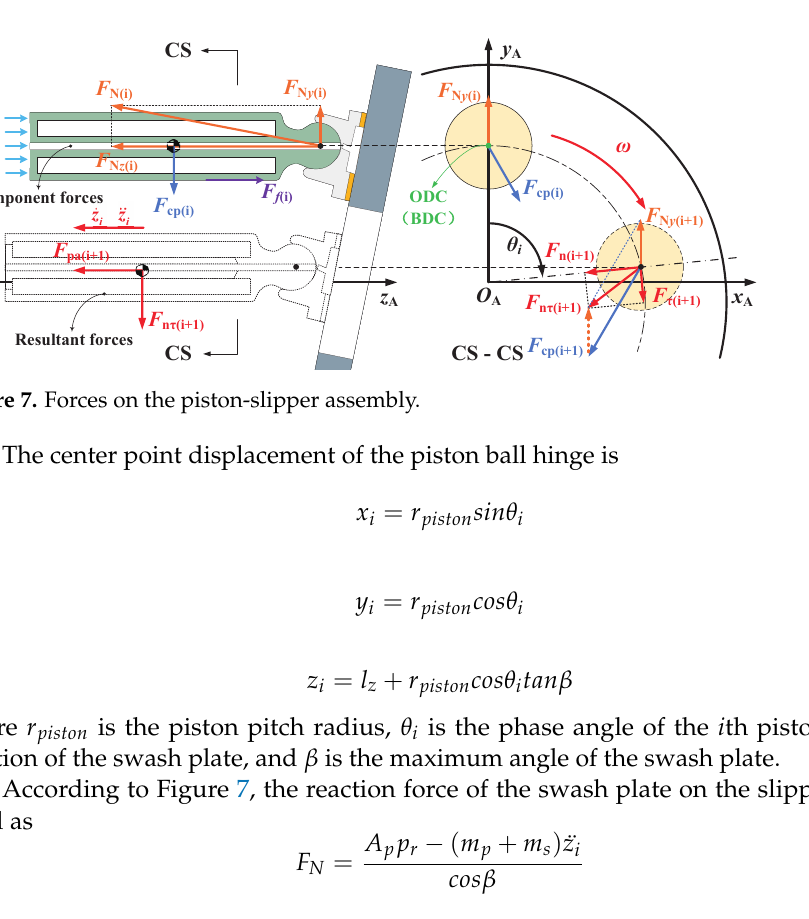
Figure 6. Forces on the cylinder block. The force on the piston-slipper assembly is shown in Figure 7 and its three-dimensional Cartesian coordinate system is the same as that of the cylinder block (Figure 6). The reaction force of the swash plate on the slipper is F N , the reaction force of the cylinder block on the piston is F cp , and the friction force of the reciprocating motion of the piston is F f . The axial, circumferential, and radial resultant forces on the piston-slipper assembly are F pa , F τ , and F n , respectively. The resultant force of the circumferential and radial resultant forces on the piston-slipper assembly is F n τ . The directions of F N and F n are shown in Figure 7 and the directions of the other parameters are the positive direction of the coordinate system.